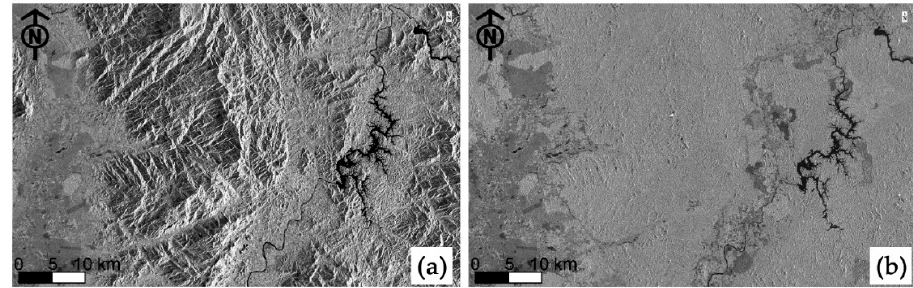
Figure 6. Topographic effect on SAR images ( a ), which has been normalized ( b ).